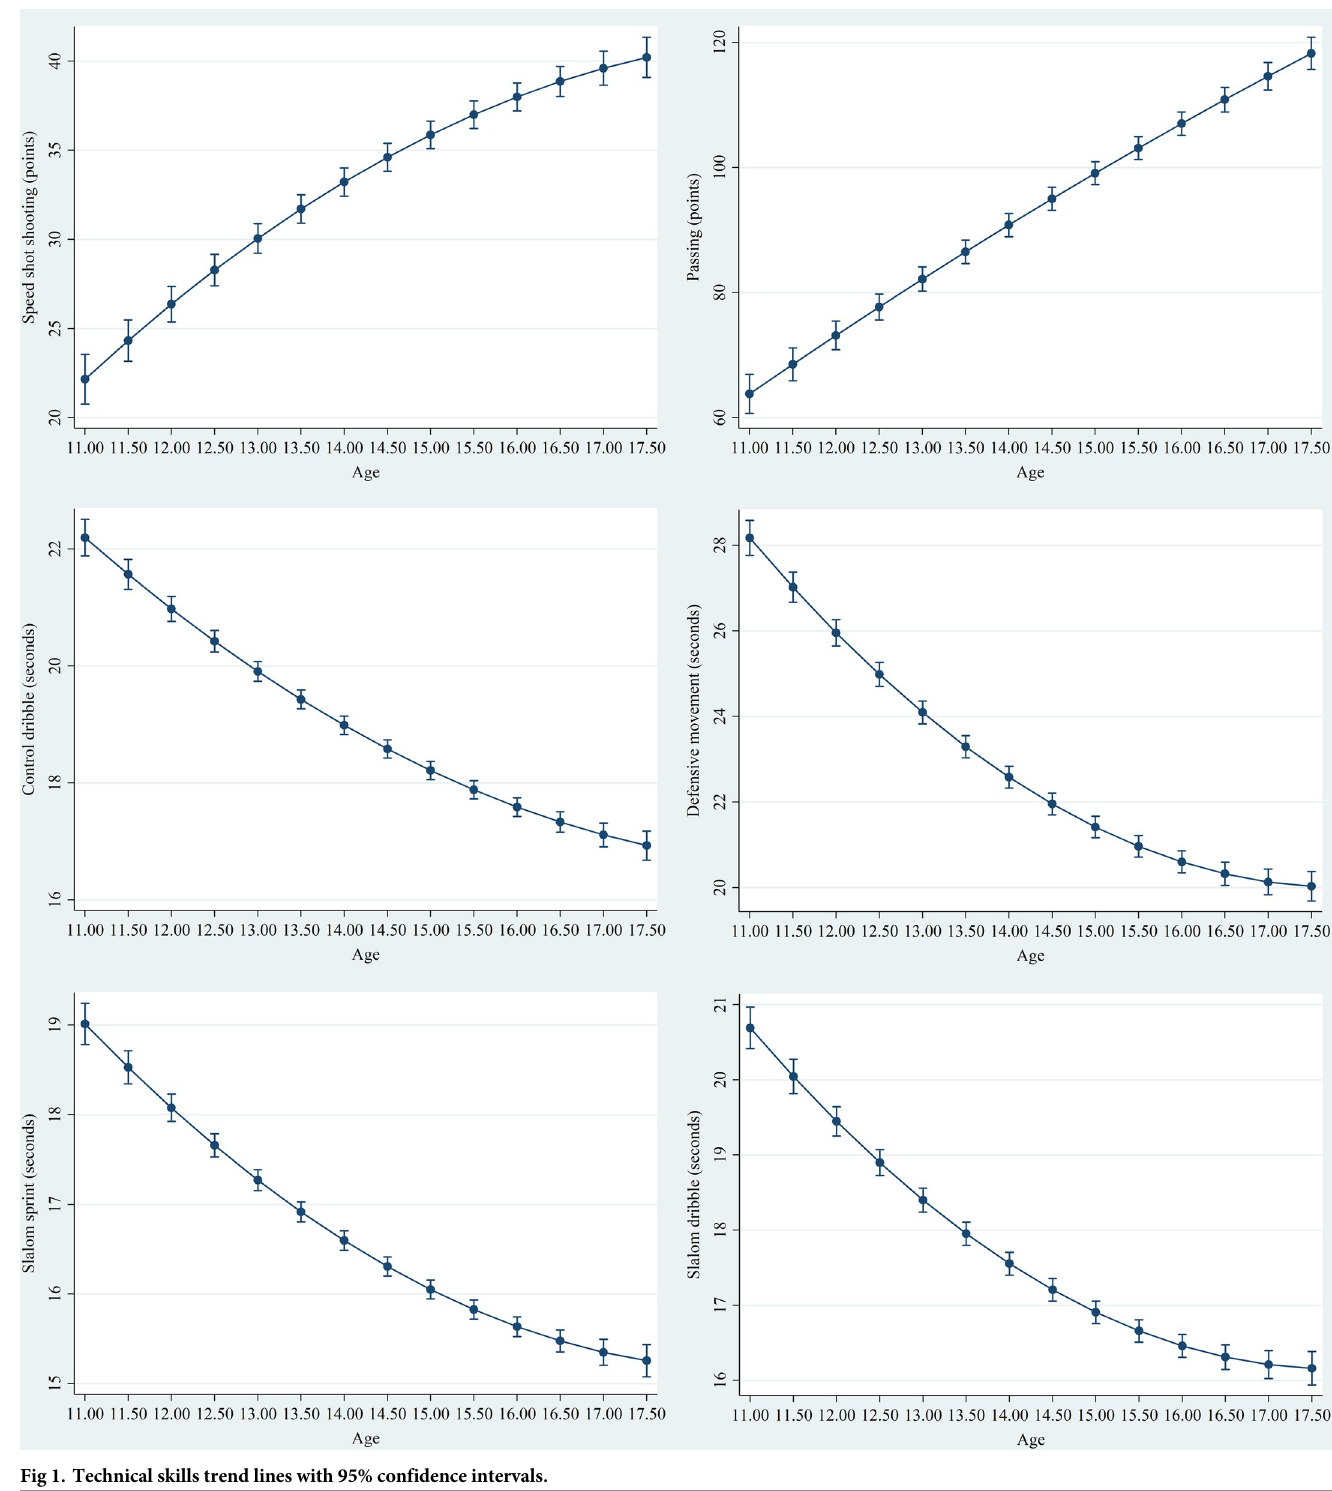
Fig 1. Technical skills trend lines with 95% confidence intervals.